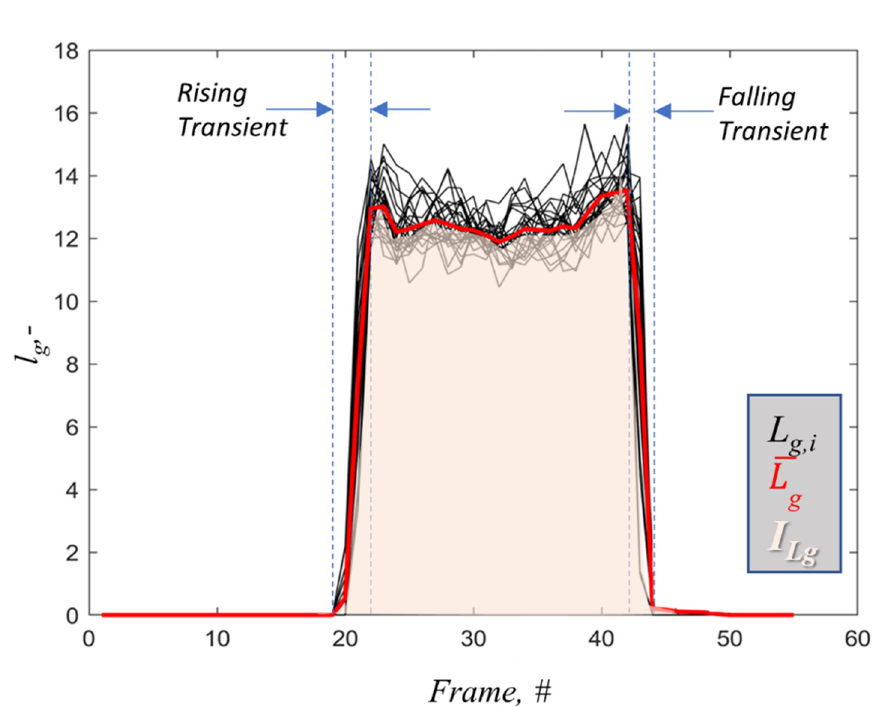
Figure 7. Trends of L g (black lines) composed by the sequence of all the grey level values l g of each discharge and the corresponding mean trend L g (red line) of all the discharges. Note that the y-axis physical quantity is the average grey level l g in Equation (2). The parameter I Lg is indicated by the red transparency area below the 𝐿(cid:3364) g curve.